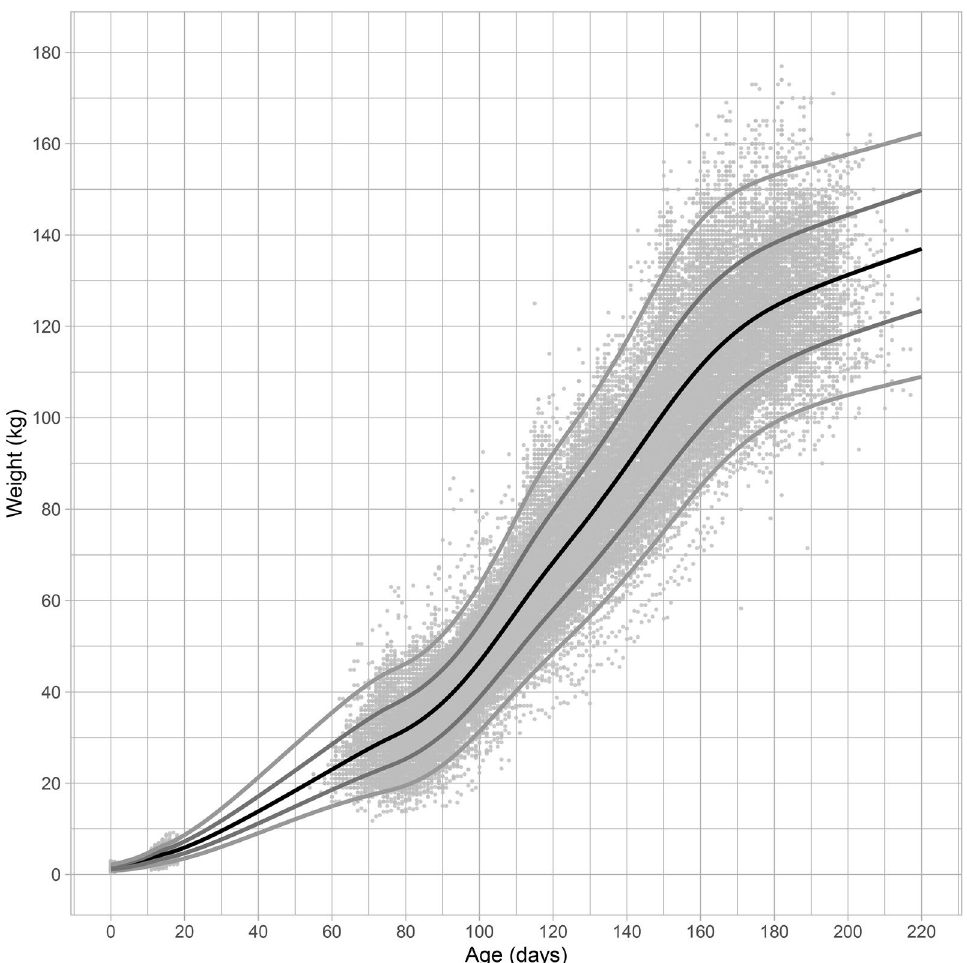
Figure 4. Reference chart for male piglets weight of age in days with the observed data-points. Farm C was excluded. The black line displays the median (50th percentile) the grey lines the 2.3rd, 16th, 84th and 97.7th percentiles,